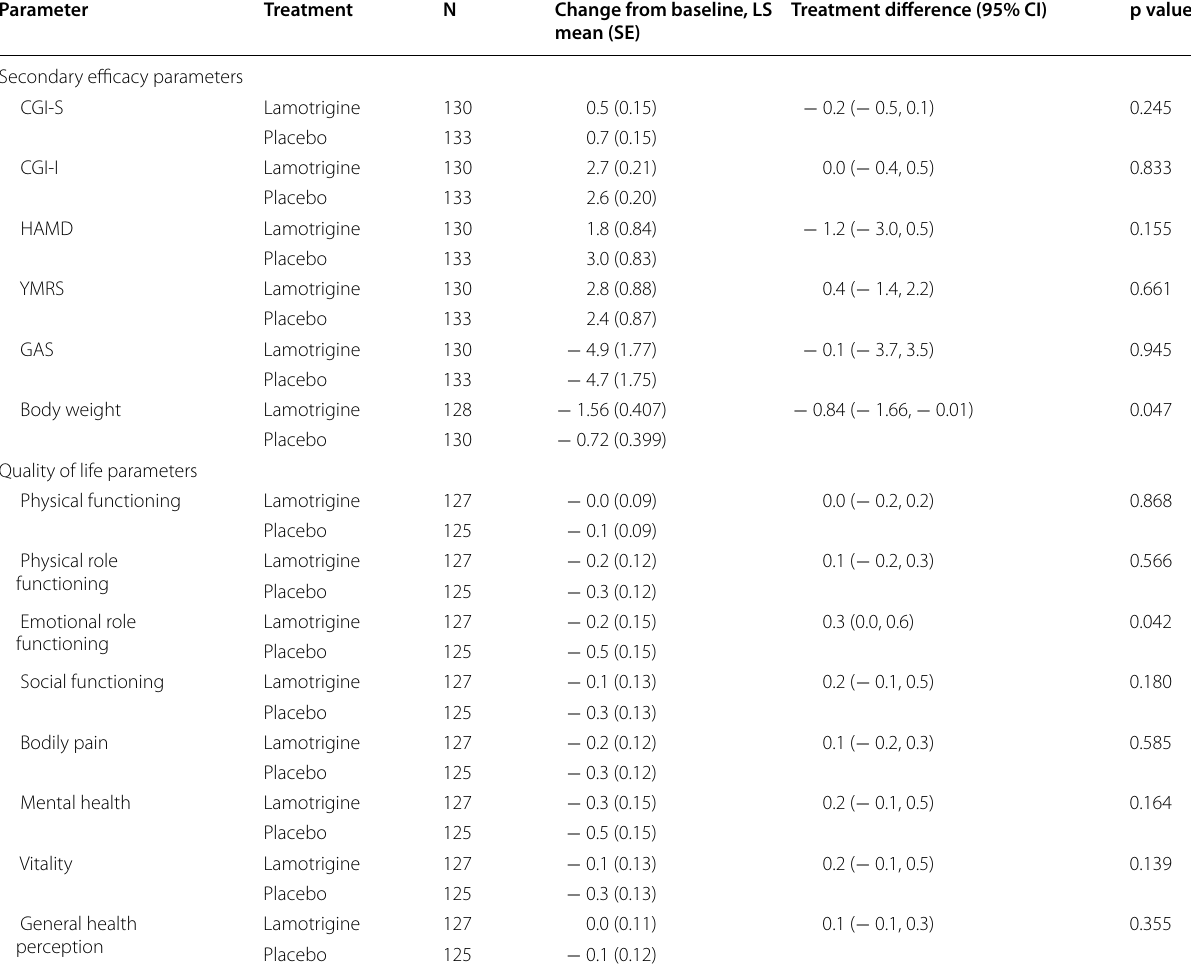
Statistical analysis performed using ANCOVA with covariates of site, CGI-S baseline score and treatment ANCOVA Analysis of covariance; CI confidence interval; CGI-I Clinical Global Impressions of Improvement; CGI-S Clinical Global Impressions of Severity; GAS Global Assessment Scale; HAMD Hamilton Depression Rating Scale; SE standard error; YMRS Young Mania Rating Scale Analysis population: RD full analysis